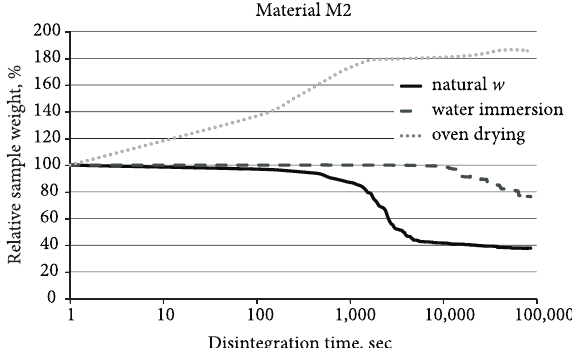
Fig. 9. Disintegration curves (Weißmann) of material M2